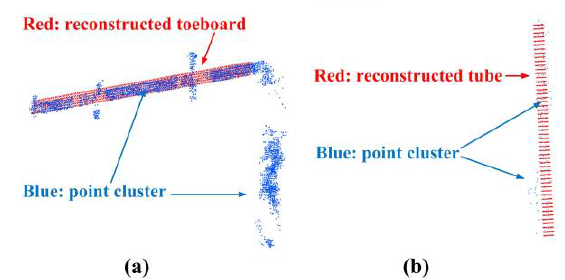
Figure 13. Examples of reconstructed objects, a) for toeboard. b) for tube.